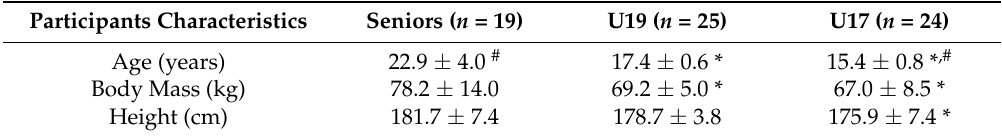
Table 1. Participant characteristics. Data shown as means ±